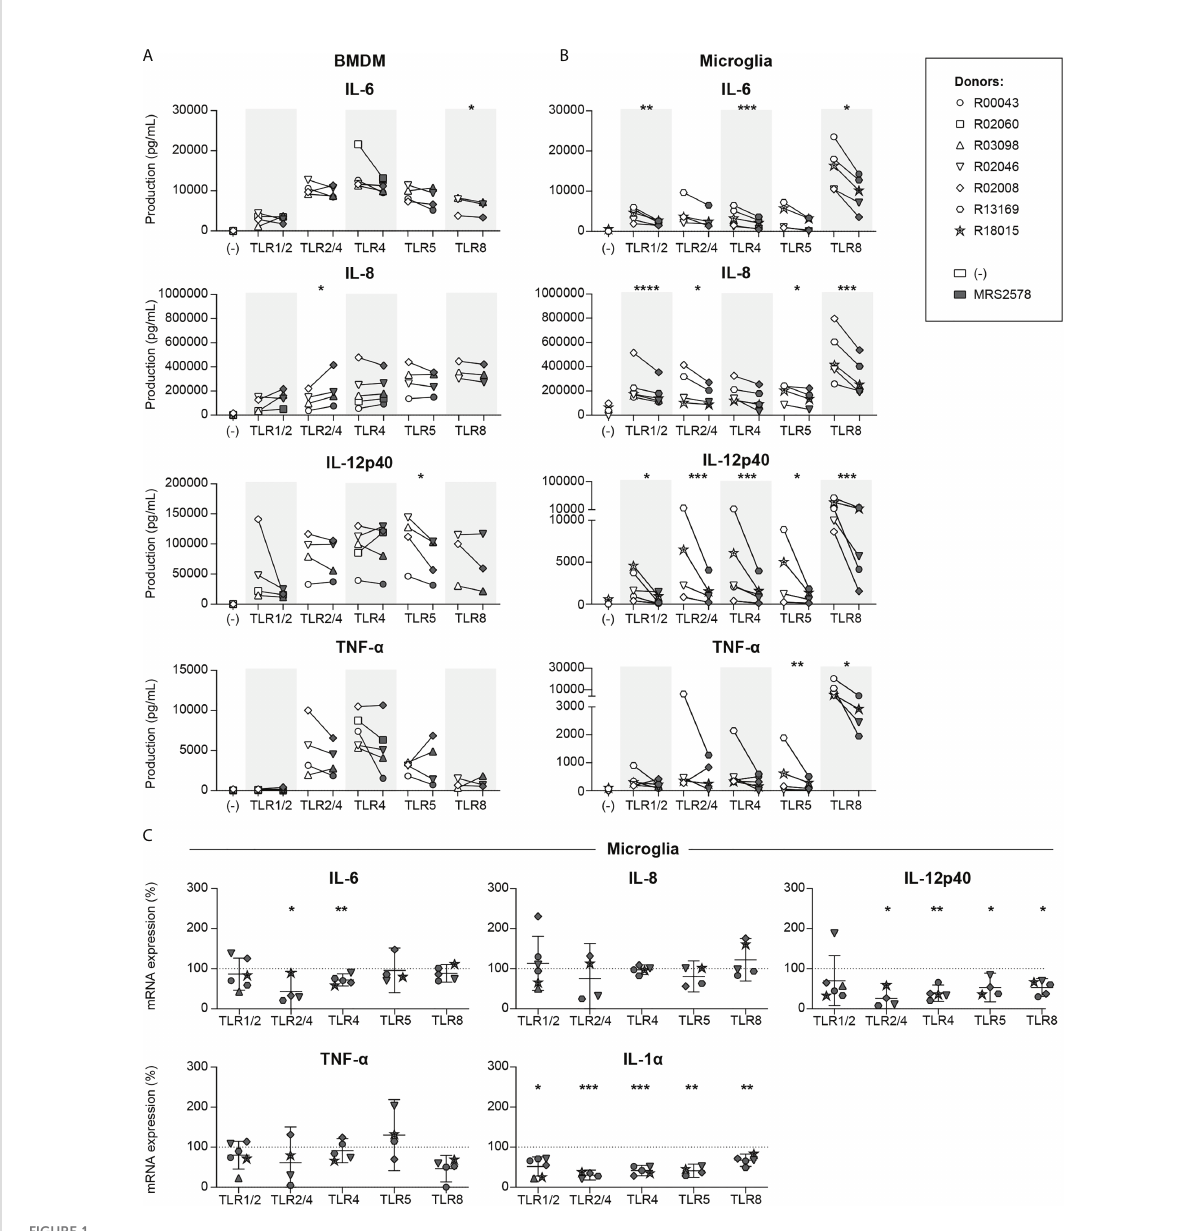
FIGURE 1 P2RY6-mediated signaling is broadly involved in microglia TLR-induced pro-in fl ammatory cytokine production and mRNA expression. Primary bone marrow-derived macrophages (BMDMs) and microglia from rhesus macaques were exposed for 16 h to different TLR ligands in the absence (white symbols) or presence (grey symbols) of 1 h pre-incubation of 5 µM P2RY6 antagonist MRS2578. TLR ligands used were 1 µg/mL PAM 3 CSK 4 (TLR1/2), 10 ng/mL LPS (TLR 2/4), 10 ng/mL ultrapure LPS (TLR4), 100 ng/mL Flagellin (TLR5) or 1 µg/mL CL075 (TLR8). IL-6, IL-8, IL- 12p40 and TNF- a production levels of (A) BMDM and (B) microglia are shown in pg/mL. Symbols represent different donors. n=3-5, paired t- test on log-transformed data, *p < 0.05, **p < 0.01, ***p < 0.005, ****p < 0.001. (C) Microglia mRNA expression levels of pro-in fl ammatory cytokines in the presence of 5 µM MRS2578 are expressed relative to mRNA expression after exposure to each TLR ligand alone (dotted line = 100%). Symbols represent different donors. Horizontal lines indicate mean values with 95% con fi dence intervals. n=4-6, paired t-test on log- transformed data, *p < 0.05, **p < 0.01, ***p <